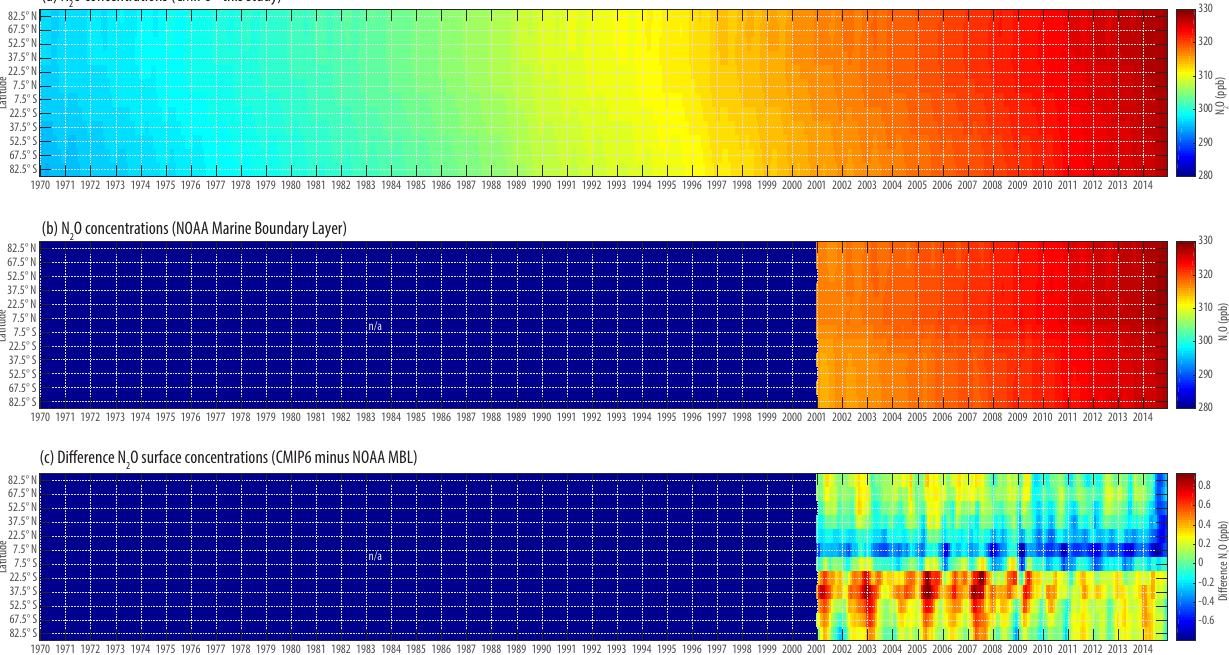
Figure 19. The comparison between latitudinal and monthly N 2 O concentrations to the NOAA Marine Boundary Layer product (b) . The differences (c) show that the CMIP6 historical GHG concentrations are slightly higher in the Southern Hemisphere (0.5ppb) and slightly lower in the tropics (0.5ppb), as the stronger latitudinal gradient from tropics to southern latitudes is not reproduced in CMIP6 data.